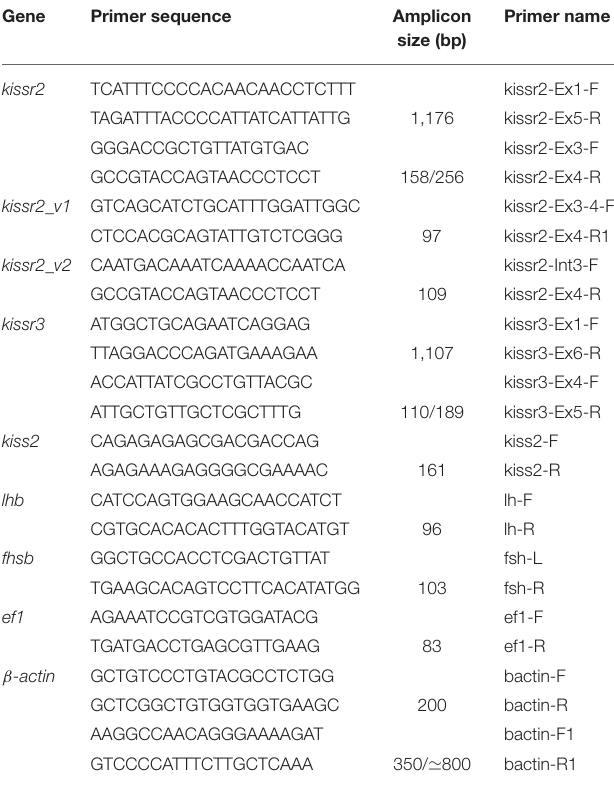
TABLE 1 | Gene-specific primers used to build the gene structure organization, detection of alternative splicing and qPCR studies. Gene Primer